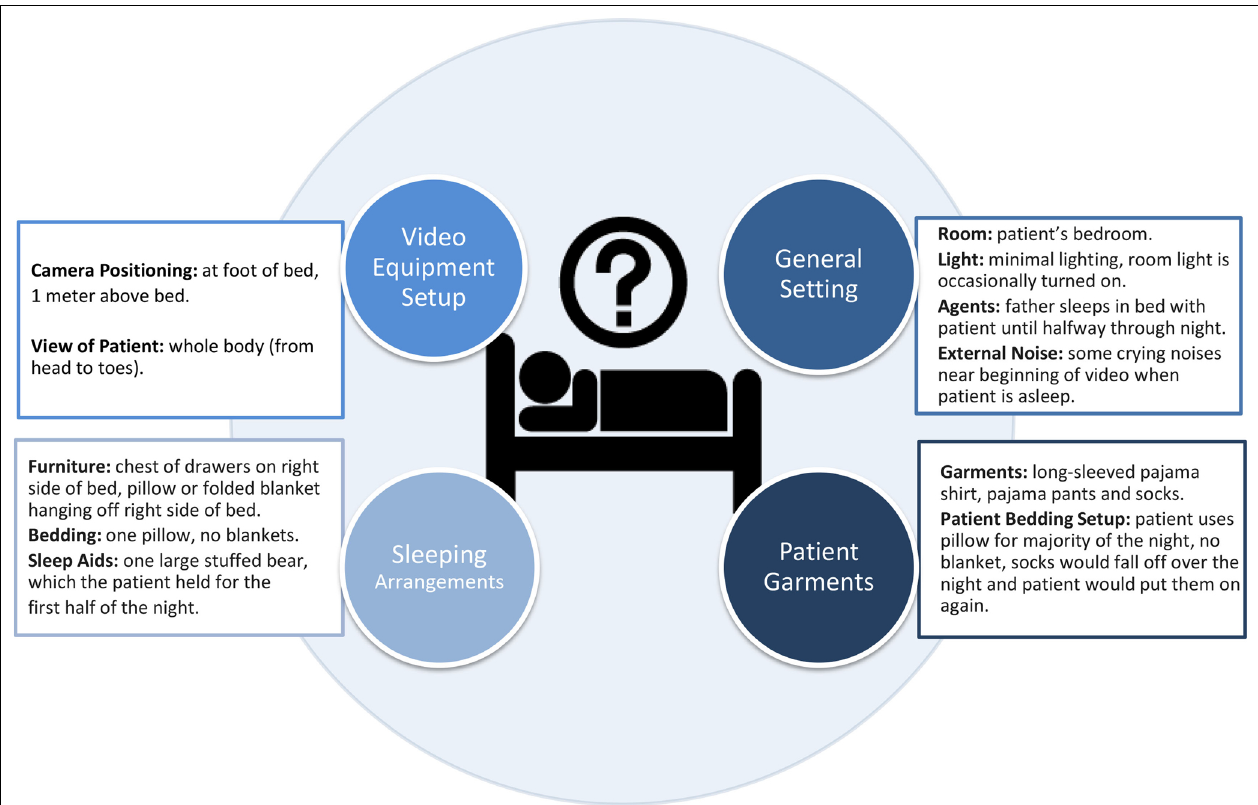
FIGURE 1 | Setup requirements and domains of qualitative analysis . This figure gives a graphical overview of the suggested setting for HVS-recordings and the targeted key features, general settings, sleeping arrangements and the patient.